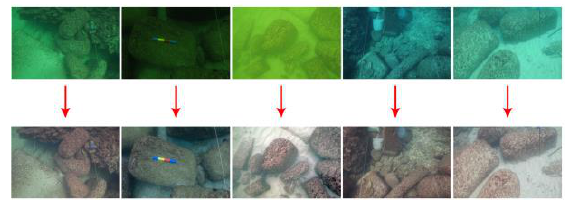
Figure 9. Above, raw images: below, photos edited using LR and PS. From the left to right: green, dark green, greenish yellow, blue, light blue (Mohamed Abd